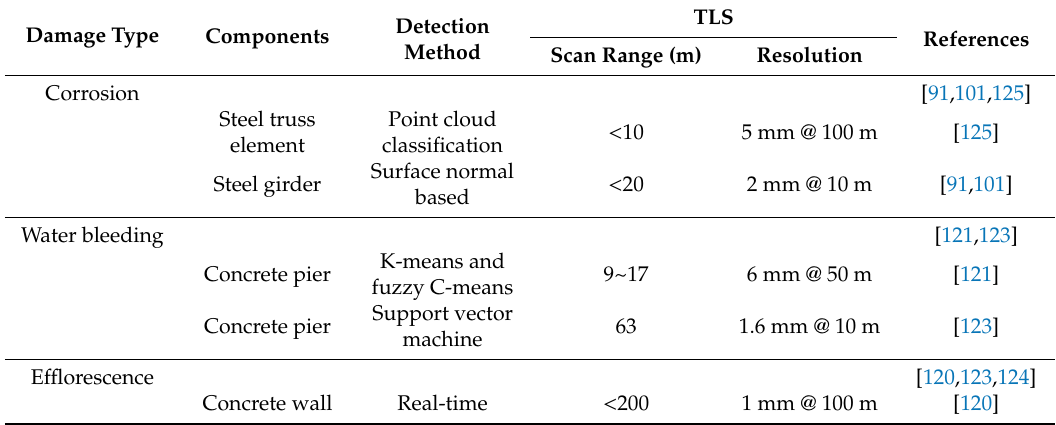
Table 7. Examples of corrosion, water bleeding, and e ffl orescence detection with various